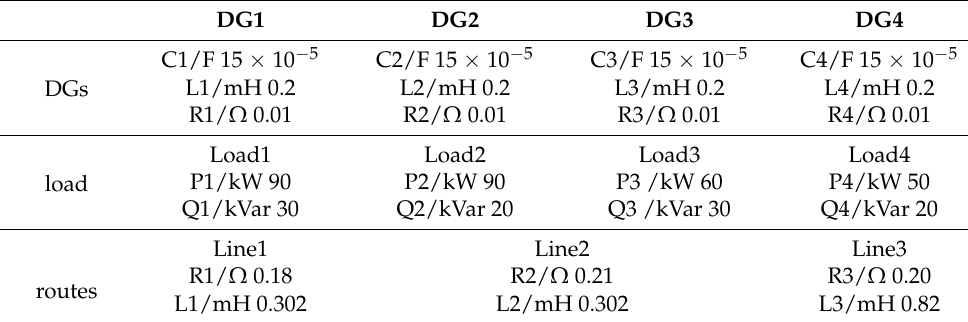
Table 1. Circuit parameters of the